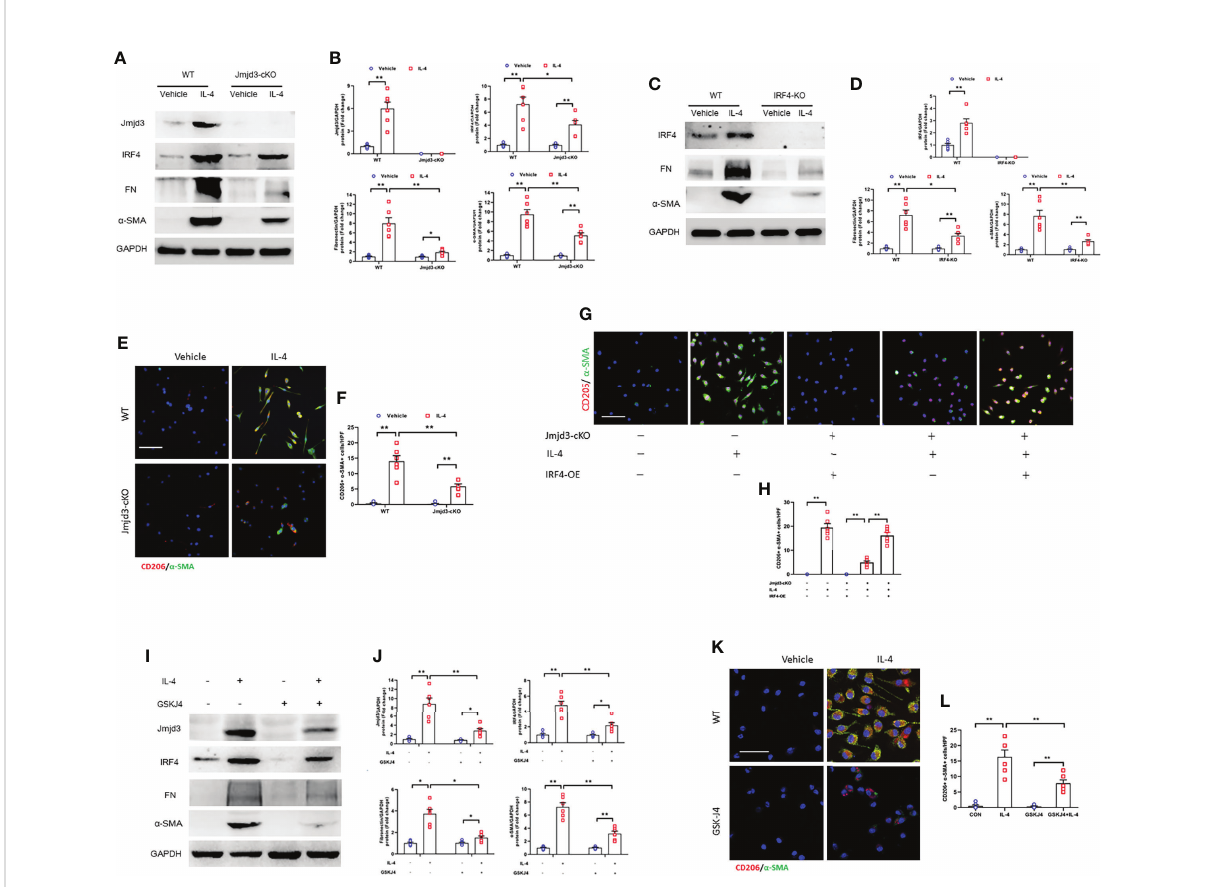
FIGURE 10 Jmjd3/IRF4 axis is highly activated in cultured monocytes. (A) Western blots bands of protein expression of Jmjd3, IRF4, fi bronectin, and a -SMA in cultured monocytes. (B) Quantitative analysis of Jmjd3, IRF4, fi bronectin, and a -SMA protein levels. (C) Western blots bands of protein expression of IRF4, fi bronectin, and a -SMA in cultured monocytes. (D) Quantitative analysis of IRF4, fi bronectin, and a -SMA protein levels. (E) Monocytes of WT or Jmjd3-cKO mice were stained for CD206 (red) and a -SMA (green). (F) Quantitative analysis of CD206 + - a -SMA + cells. (G) Monocytes of WT or Jmjd3-cKO mice after IL-4 (50 ng/ml) or IRF4 overexpression were stained for CD206 (red) and a -SMA (green). (H) Quantitative analysis of CD206 + - a -SMA + cells. (I) Western blots bands of protein expression of Jmjd3, IRF4, fi bronectin, and a -SMA in cultured monocytes. (J) Quantitative analysis of Jmjd3, IRF4, fi bronectin, and a -SMA protein levels. (K) Monocytes of WT mice after IL-4 or (and) GSKJ4 treatment were stained for CD206 (red) and a -SMA (green). (L) Quantitative analysis of CD206 + - a -SMA + cells. * P <0.05 or ** P <0.01; n = 6; Bar = 50 m m. WT, wild-type; cKO, conditional knockout; KO, knockout; HPF, high-power fi